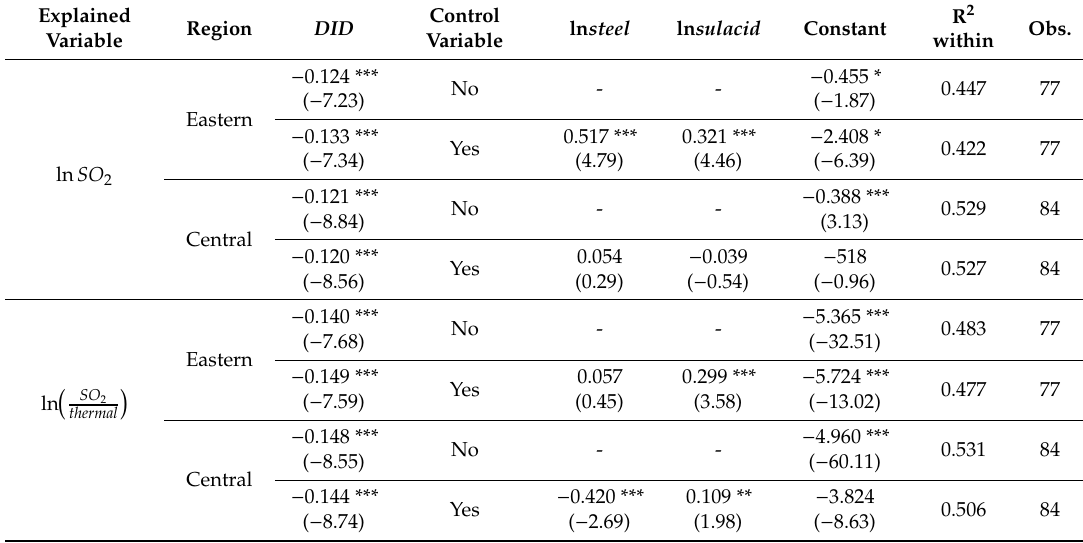
Table 4. Regression outcome for the ULE’s reduction e ff ect on SO 2